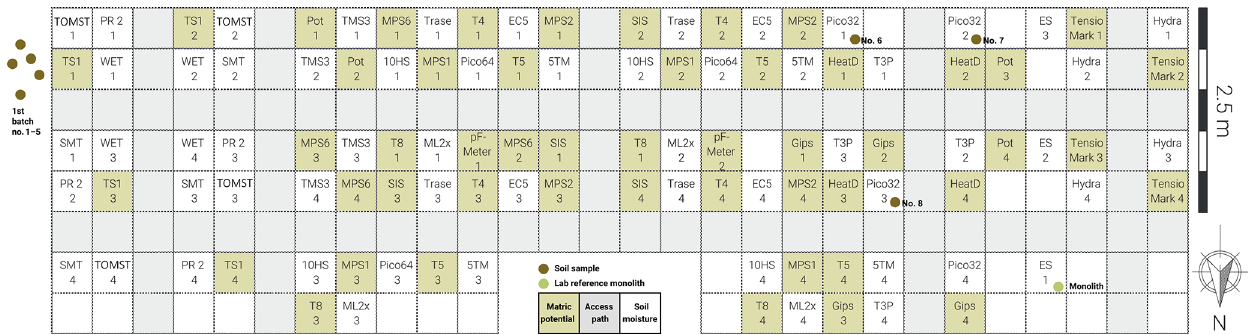
Figure 2. Layout of the sensor comparison field site. Each grid cell covers 0 . 5m × 0 . 5m. All sensors are placed at 0.2m depth. Positions of soil samples marked with dots. Total covered area 14m in east–west and 4m in north–south